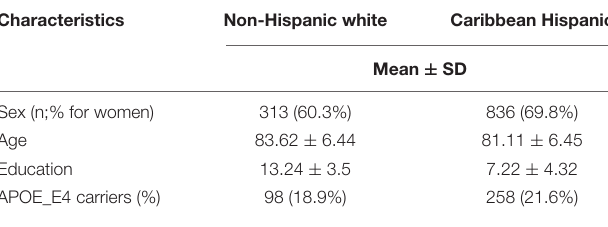
TABLE 1 | Characteristics of study